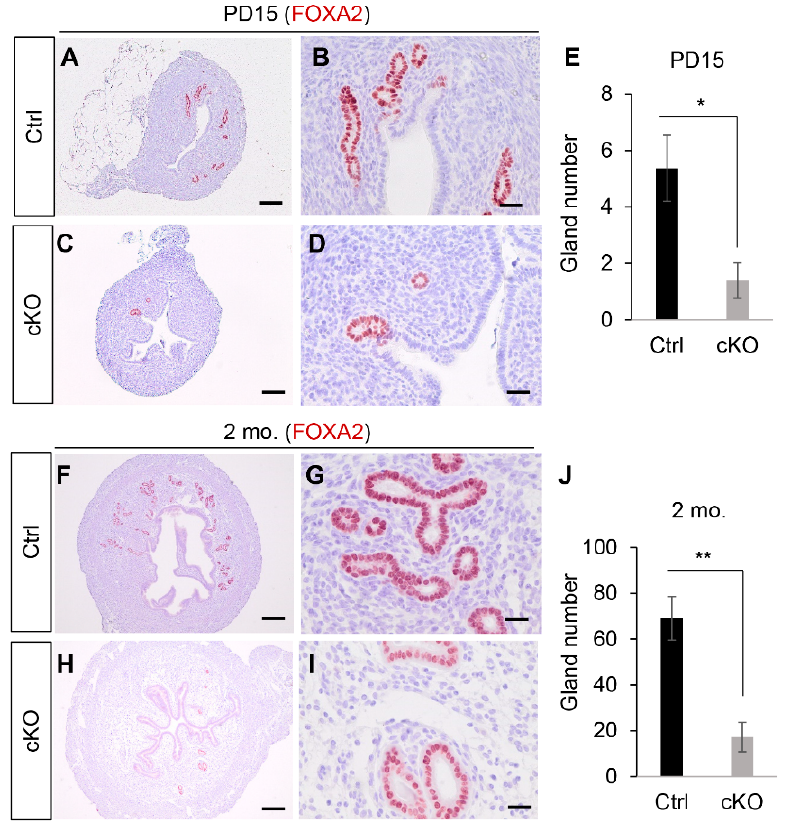
Figure 1. Glandular defects of the uterus in Ezh2 Amhr2 ‐ Cre cKO mice. ( A–D ) Immunostaining of FOXA2 using uteri from control and Ezh2 Amhr2 ‐ Cre cKO mice at PD15. Panels ( B , D ) are higher power images for panels ( A , C ), respectively. Scale bar = 25 μ m ( B , D ) and 100 μ m ( A , C ). At least three animals for each genotype were examined. ( E ) Quantification of the number of uterine glands using control and Ezh2 Amhr2 ‐ Cre cKO mice at PD15. n = 3. Data are mean ± s.e.m. * p < 0.05. ( F–I ) Immunostaining of FOXA2 using uteri from control and Ezh2 Amhr2 ‐ Cre cKO mice around 2 months of age. Panels ( G , I ) are higher power images for panels ( F , H ), respectively. Scale bar = 25 μ m ( G , I ) and 250 μ m ( F , H ). At least three animals for each genotype were examined. ( J ) Quantification of the number of uterine glands using control and Ezh2 Amhr2 ‐ Cre cKO mice around 2 months of age. n = 5. Data are mean ± s.e.m. ** p < 0.01.